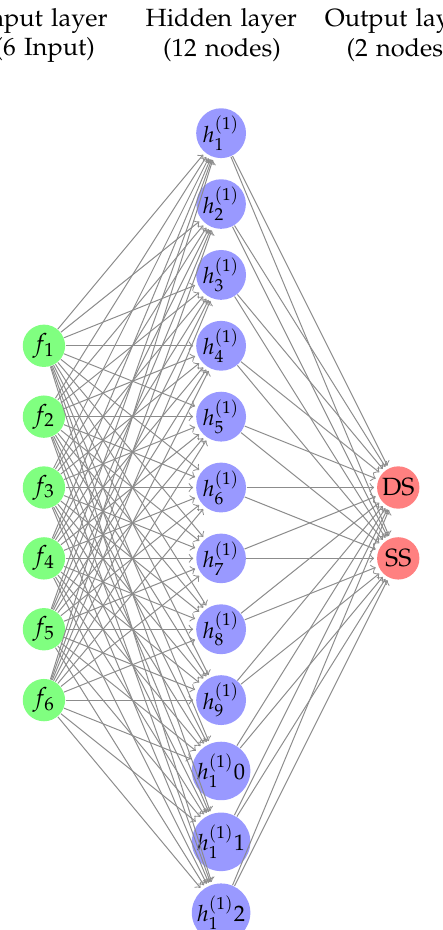
Figure 4. SSN Architecture for Signal